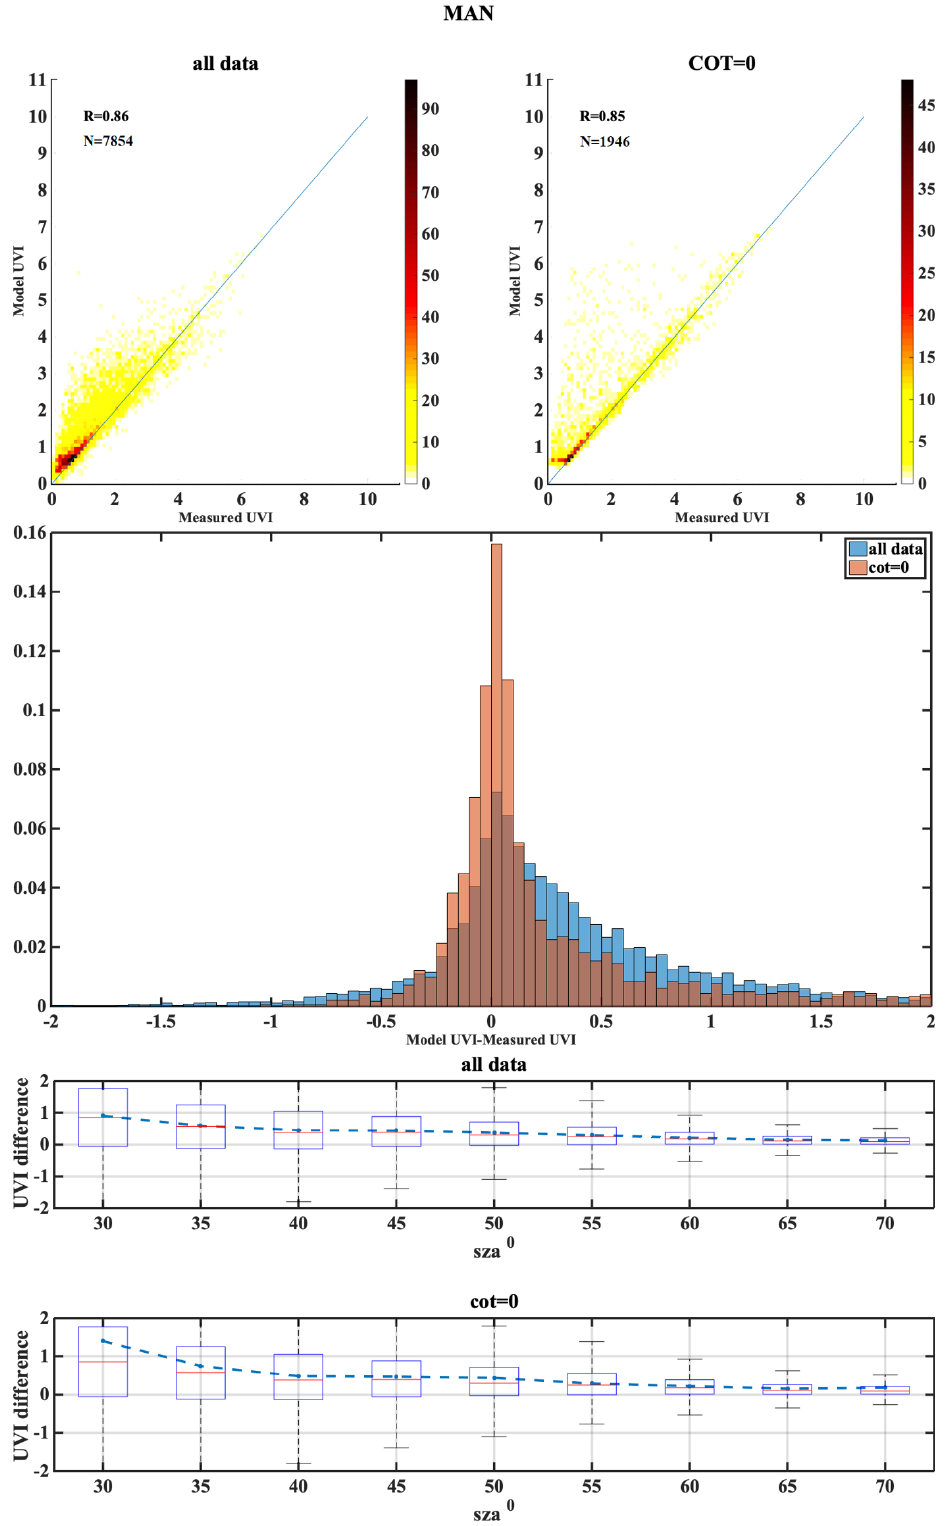
Figure A11. Same as above but for the MAN